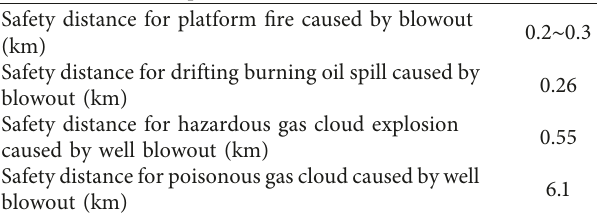
0.2 ∼ 0.3 0.26 0.55